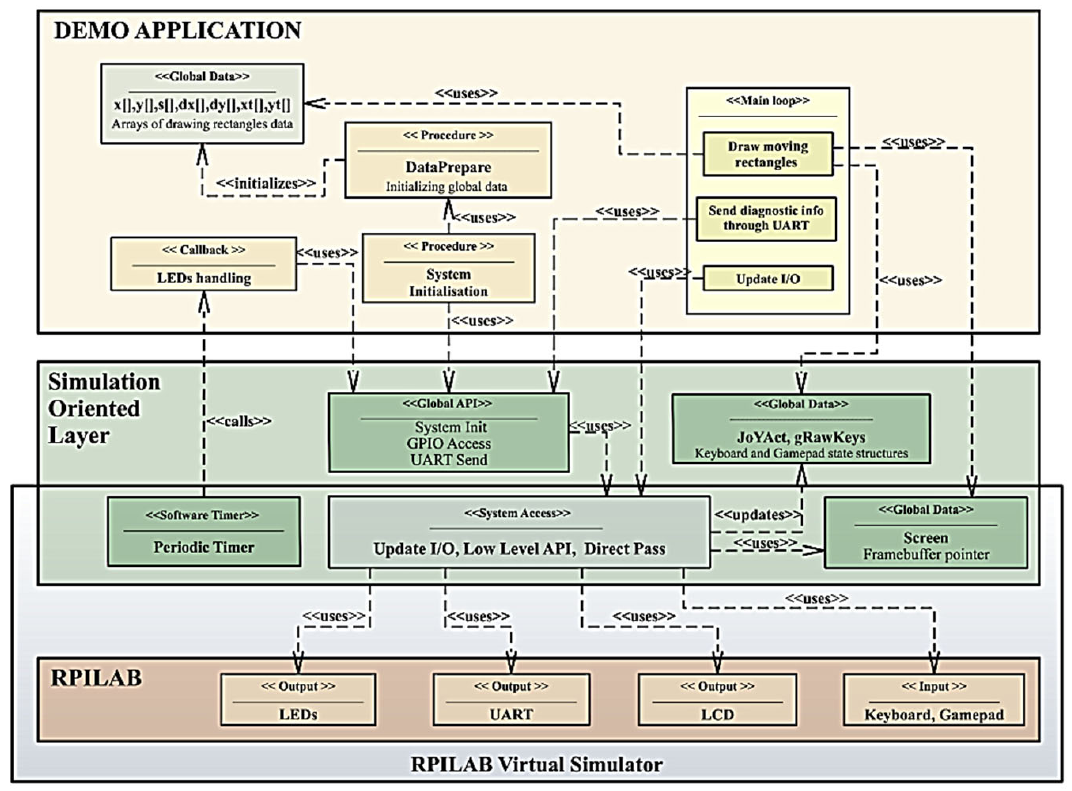
Figure 13. Demo-software-architecture diagram for real RPILAB and its virtual Figure 13 . Demo ‐ software ‐ architecture diagram for real RPILAB and its virtual simulator .